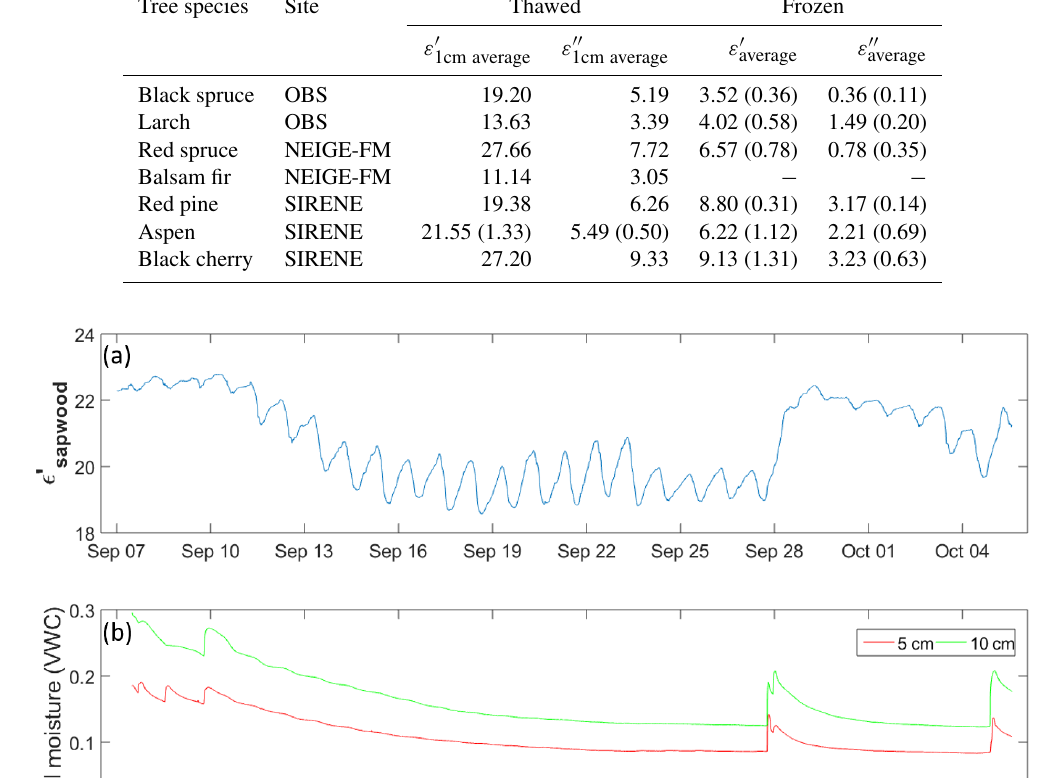
Table 3. Complex L-band relative permittivity for different tree species in thawed and frozen states. The standard deviation of the data is in parentheses when the number of trees probed was relevant for this statistic. ε 1cmaverage represents the average value of the trunk permittivity through the first centimeter under the bark, while ε average represents the average value across the whole radial profile as seen in Fig. 7. All data were taken between 15:00 and 18:00 local time. Detailed data are available in the Supplement for thawed trees (Figs. S1 to S5) and frozen trees (Fig. S7).